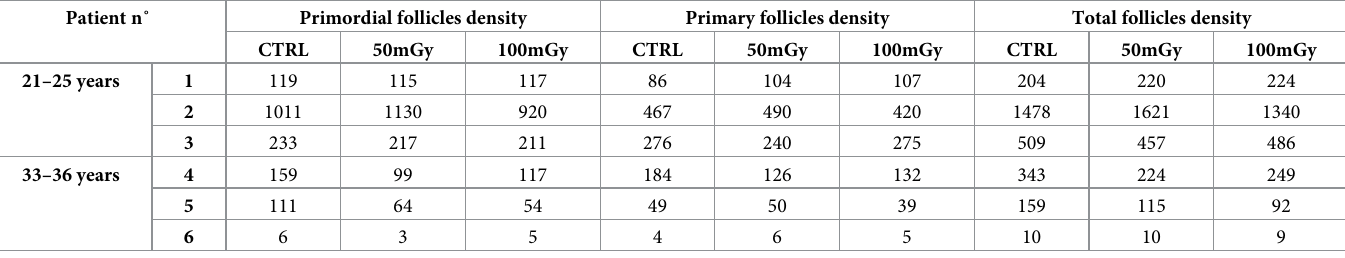
Data from 6 patients are reported. CTRL: Human ovarian tissue not exposed to